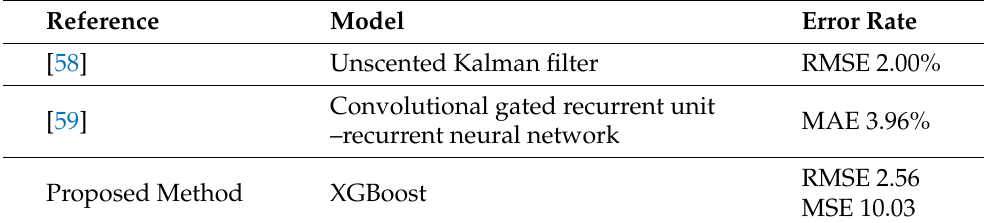
Table 6. Comparison of error rates between previous approaches and the proposed